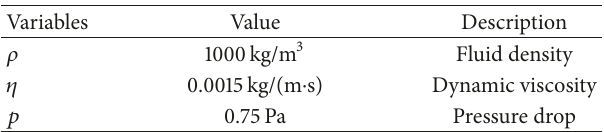
Table 2: Model parameters.